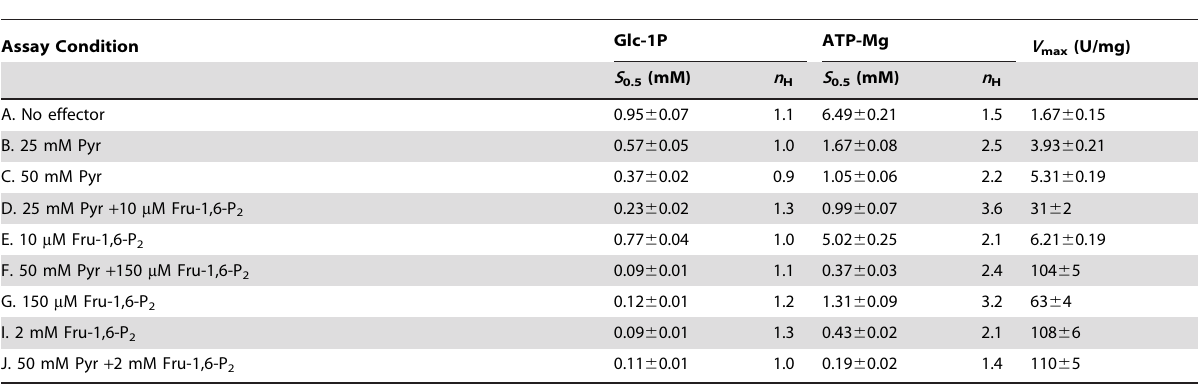
Figure 1. E.coli ADP-Glc PPase Pyr saturation curves in the absence (control, # ) or presence of Fru-1,6-P 2 (10 m M, & ; or 30 m M, . ). Other conditions for the assays were as described under Materials and Methods. doi:10.1371/journal.pone.0103888.g001 Table 1. Kinetic parameters for E. coli ADP-Glc